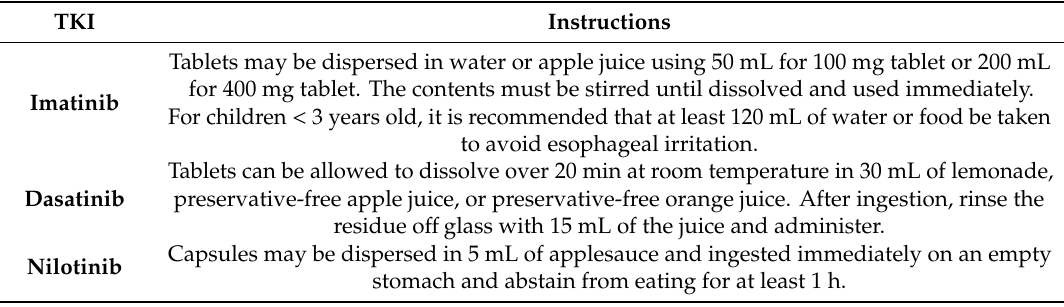
Table1. Instructionstoprepareextemporaneousoralliquidsuspensionsoftyrosinekinaseinhibitors(TKIs)[94]. TKI